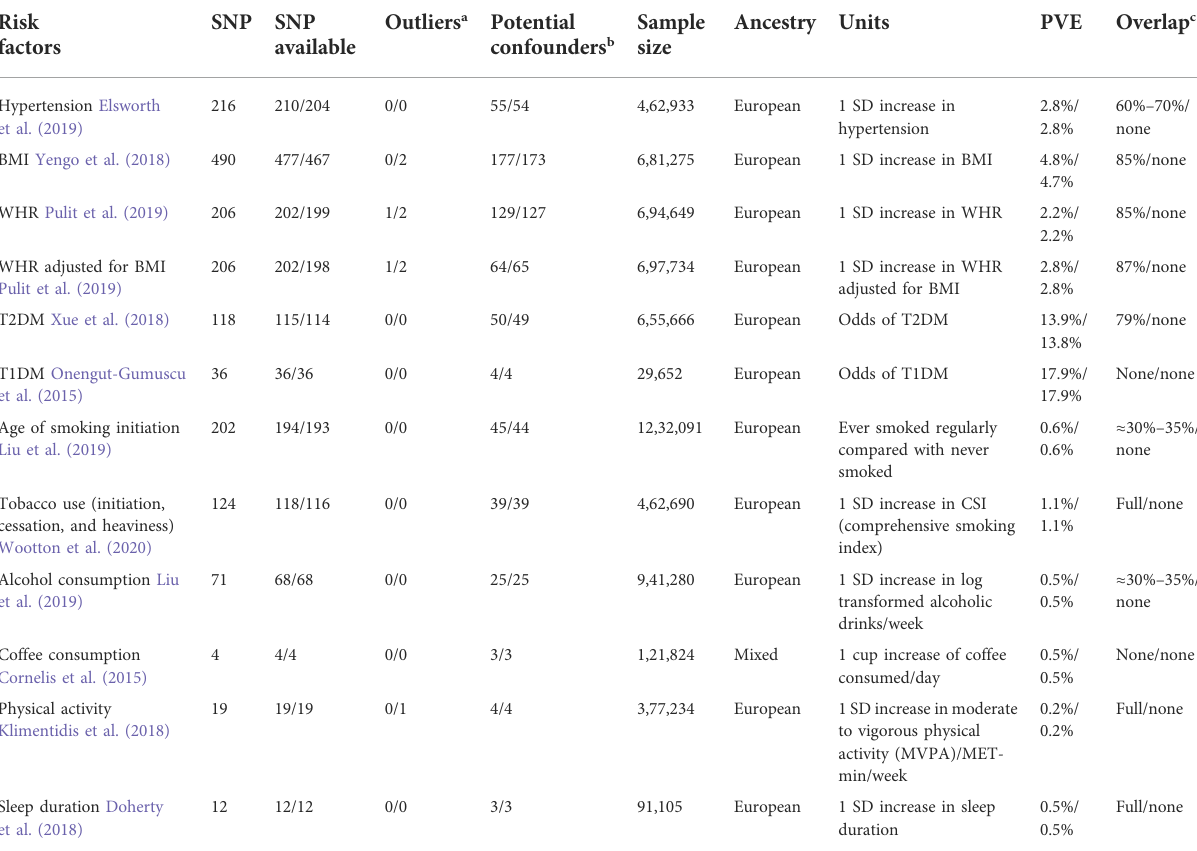
TABLE 1 Overview of the data sources of the instrumental variables used in the MR study (UK